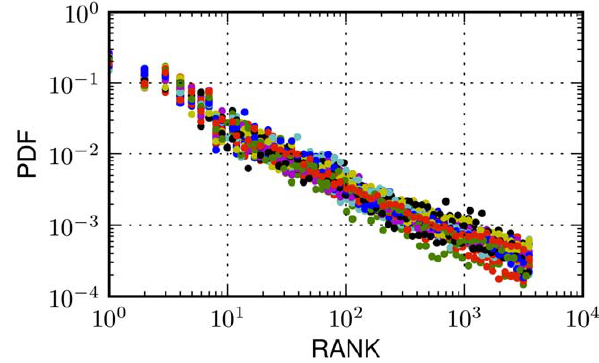
Figure 7. Rank distributions in urban environments. Superim- position of the probability density functions (PDF) of rank values the thirty-four cities analyzed in the Foursquare dataset. A decreasing trend for the probability of a jump at a place as its rank value increases is common. The trend remains stable despite the large number of plotted cities and their potential differences with respect to a number of variables such us number of places, number of displacements, area size, density or other cultural, national or organizational ones.